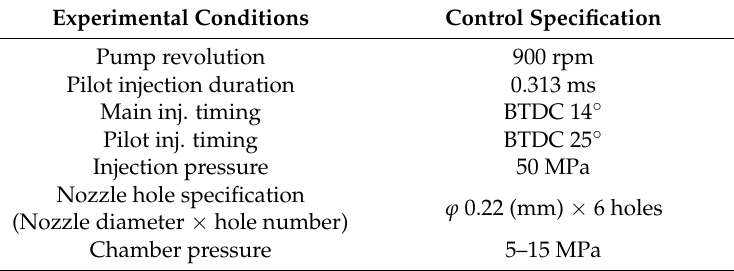
Table 4. Experiment condition.